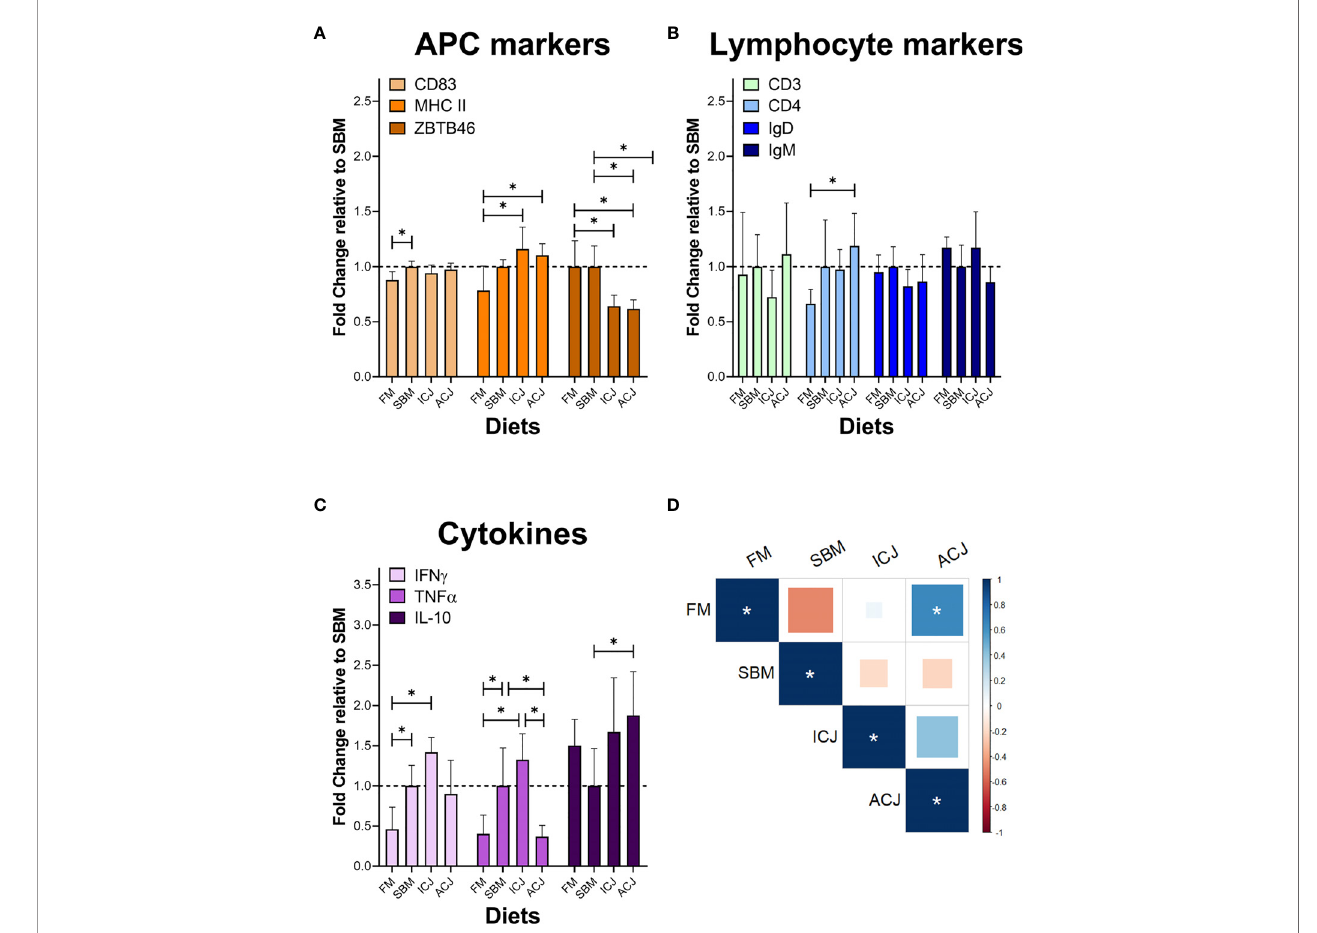
FIGURE 6 | Protein detection of immunological markers in spleen by indirect ELISA. (A) Antigen-presenting cell (APC) markers. (B) Lymphocyte markers. (C) Cytokines. (D) Correlation between diets using the data from different immunological markers (Degrees of freedom = 8). In (A – C) * shows signi fi cant differences among dietary groups (p < 0.05). In (D) * signi fi cant correlation (p <